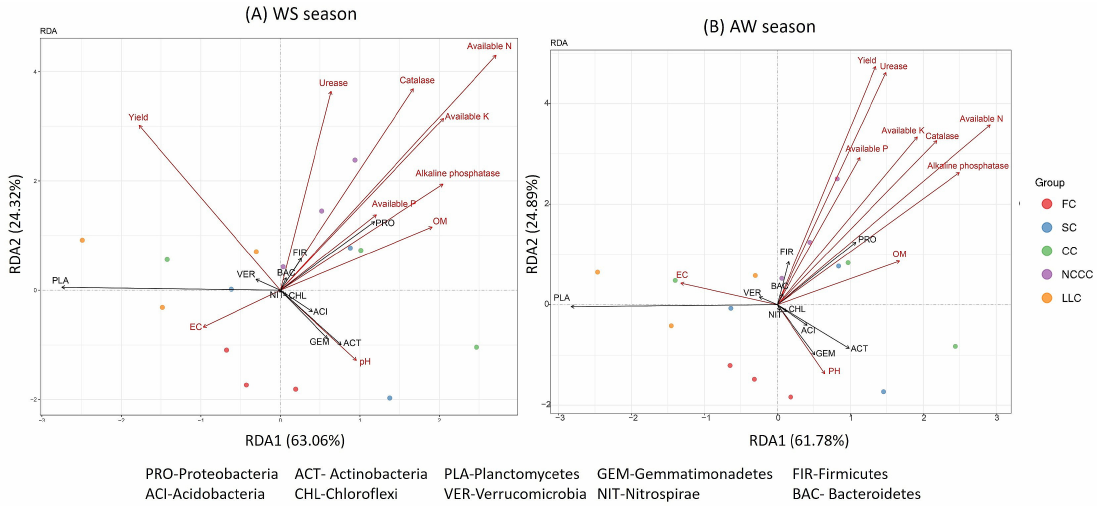
Figure 6. Redundancy analysis (RDA) of soil bacterial community structure associated with soil properties. ( A ), RDA derived from WS season-2017 samples; and ( B ), RDA derived from AW season-2017